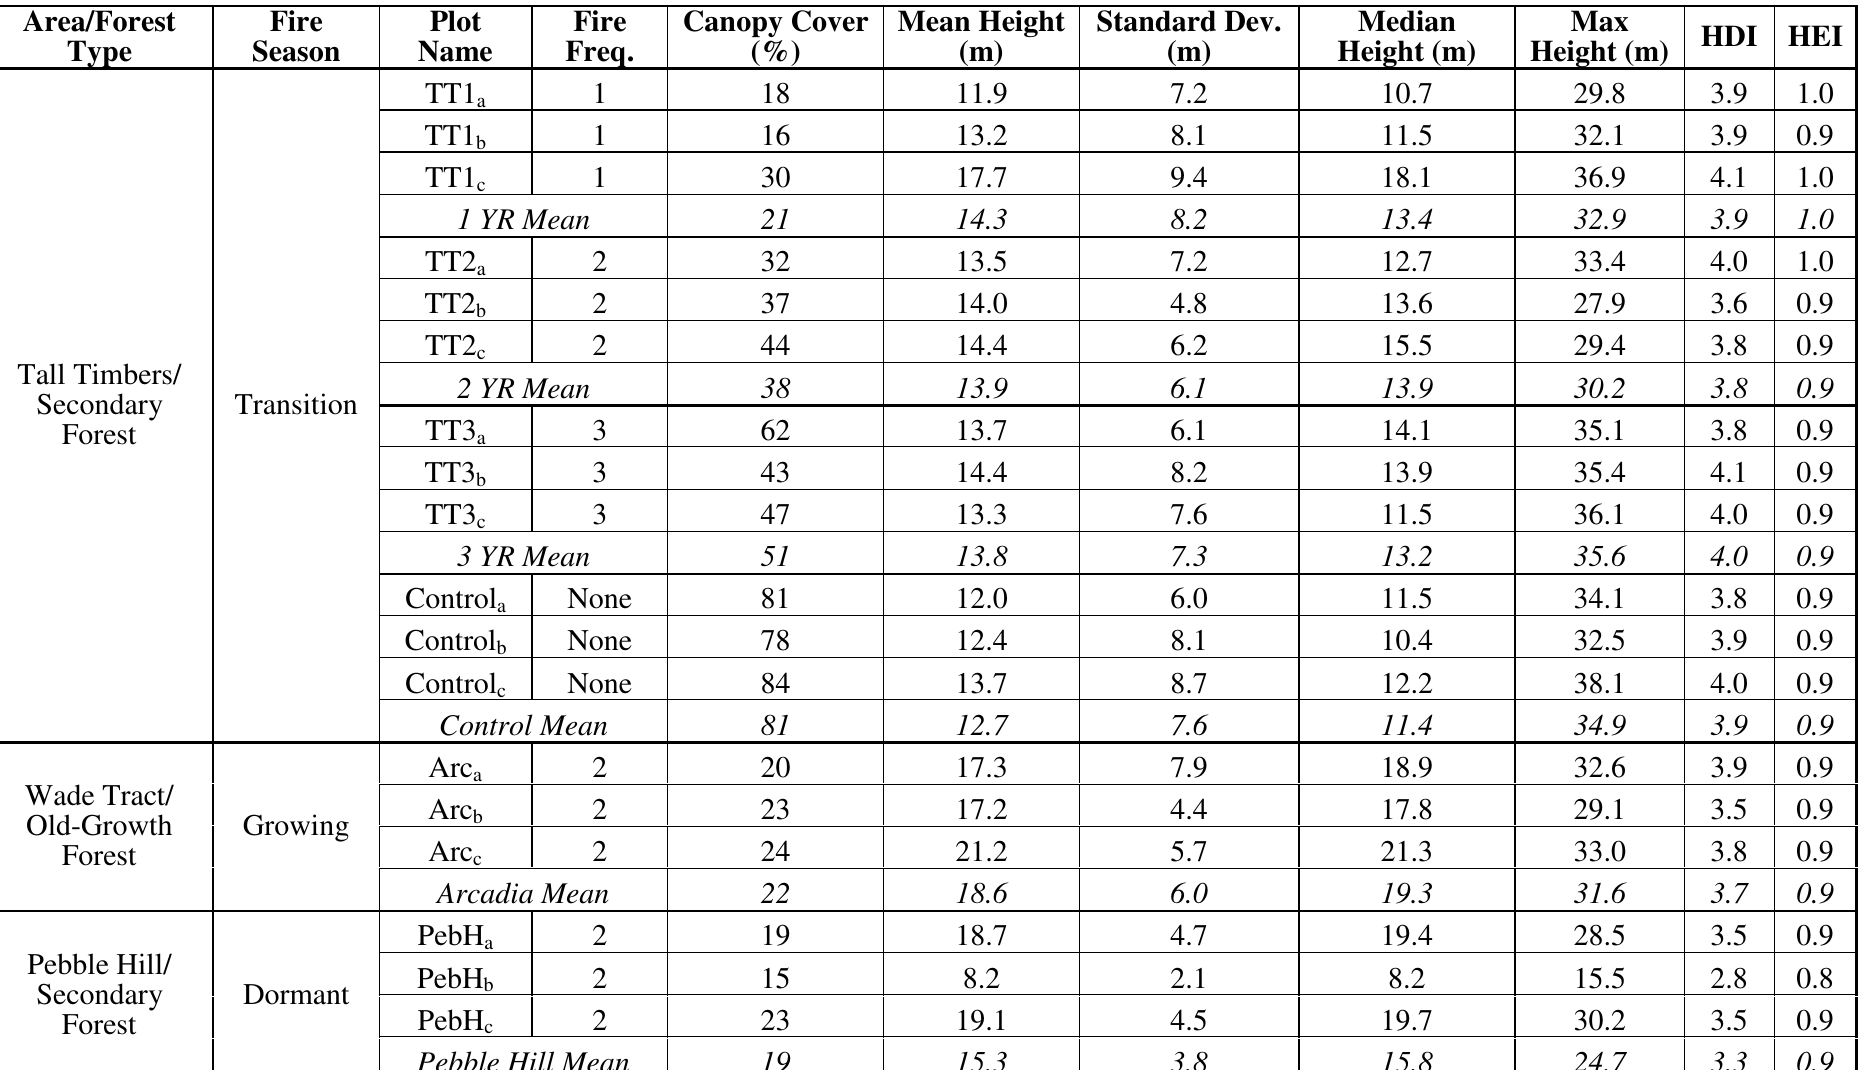
Table 2. Portable LiDAR Metrics for the Stoddard Fire Plots (TTRS), Wade Tract (Arcadia) and Pebble Hill Plantation managed plots.